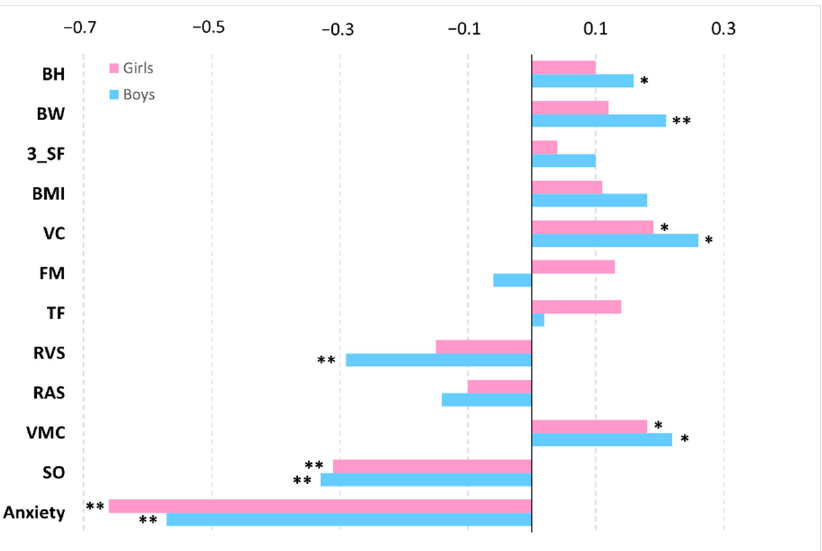
Figure 1. Relationships between fear of water, morphological characteristics, coordination motor abilities of girls and boys, and achievement level in swimming (Spearman’s rho correlation coeffi-